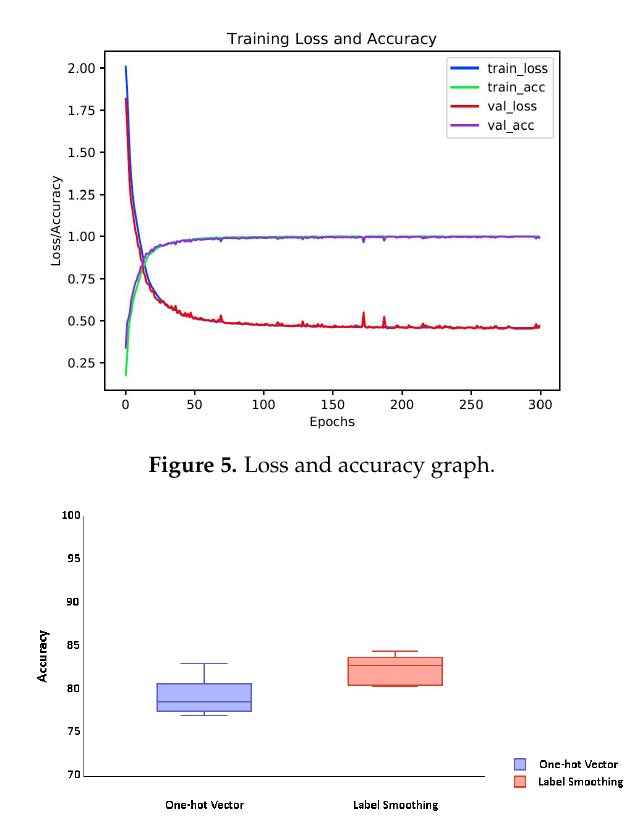
Figure 6. Cross validation